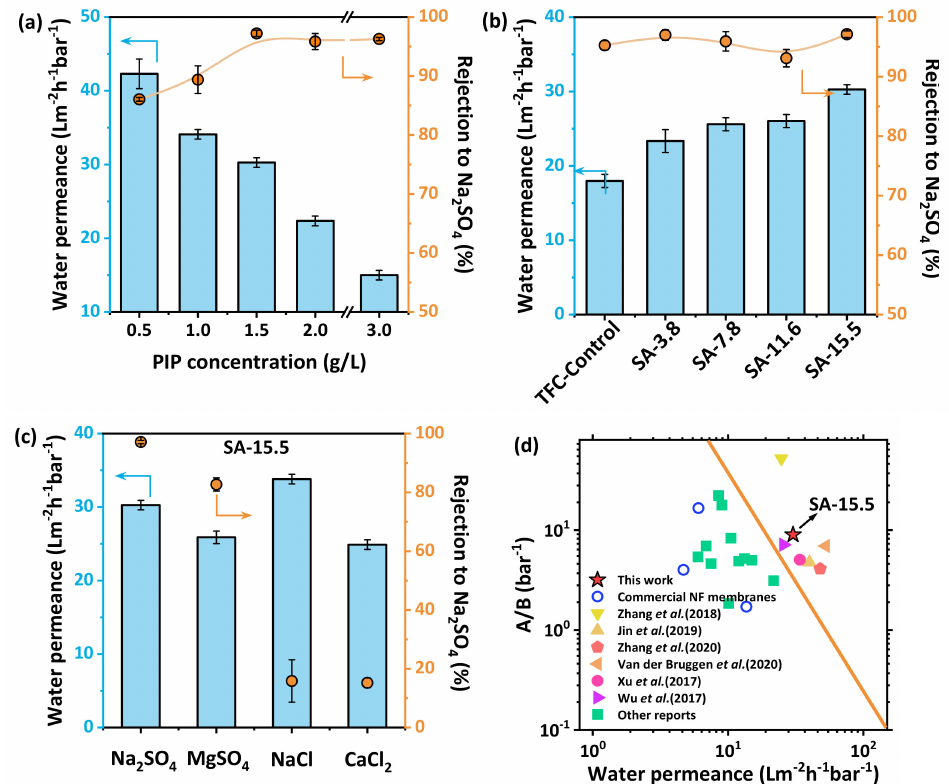
Figure 6. Nanofiltration properties of the SA–TFC membranes: ( a ) The Na 2 SO 4 separation prop- erties of SA–TFC membranes synthesized at different concentration of PIP (SA is fixed at 15.5 g/L); ( b ) Nanofiltration performance of SA–TFC membranes; ( c ) Separation performance of SA- 15.5 membranes for different salt solutions; ( d ) Summary of water permeance and water/Na 2 SO 4 permselectivity (A/B) of SA-15.5 and other high-performance nanofiltration membranes prepared by interfacial polymerization. Our membranes were tested under 4 bar operating pressure and